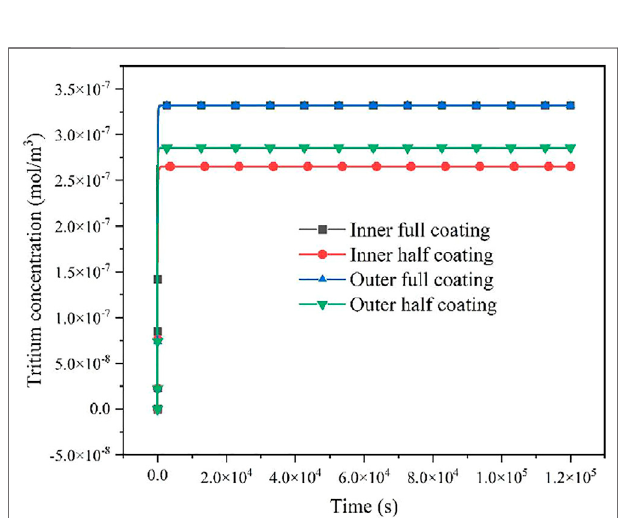
FIGURE 15 | Axial tritium distribution in the FeCrAl cladding at 120,000 s.